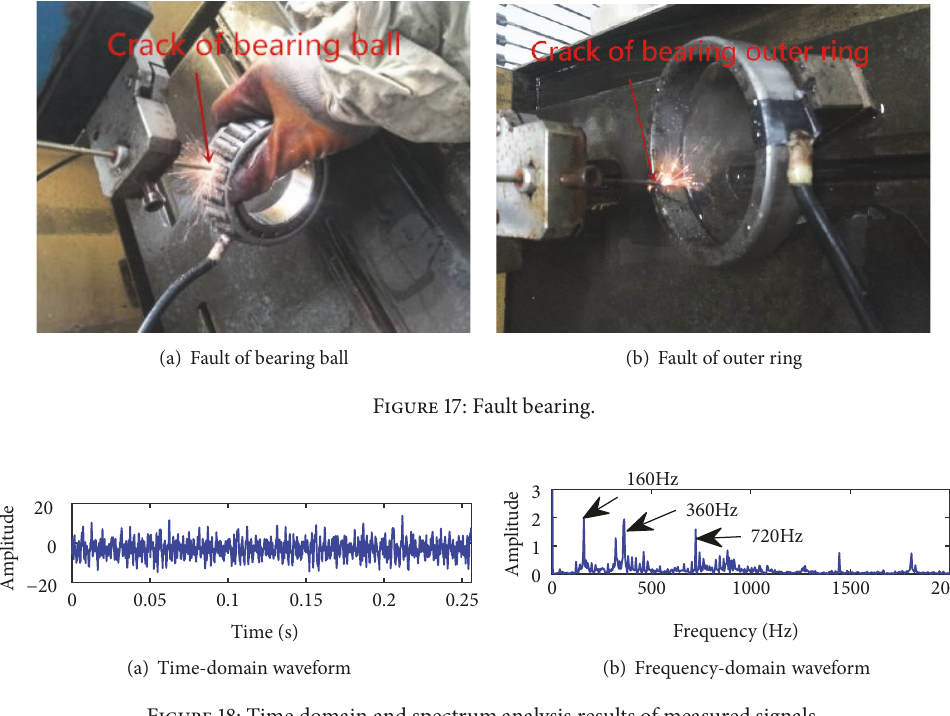
Figure 18: Time domain and spectrum analysis results of measured signals.